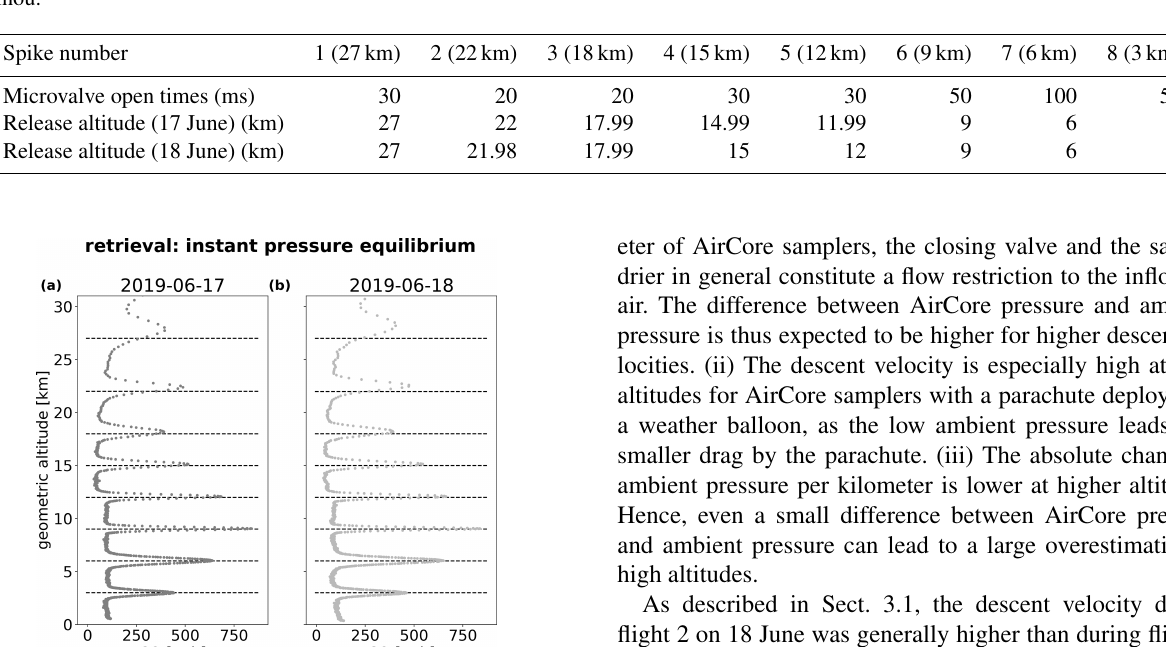
Table 1. Release altitudes (km) and microvalve open times (ms) for the different spikes for the two flights on 17 June and 18 June 2019 in Traînou.